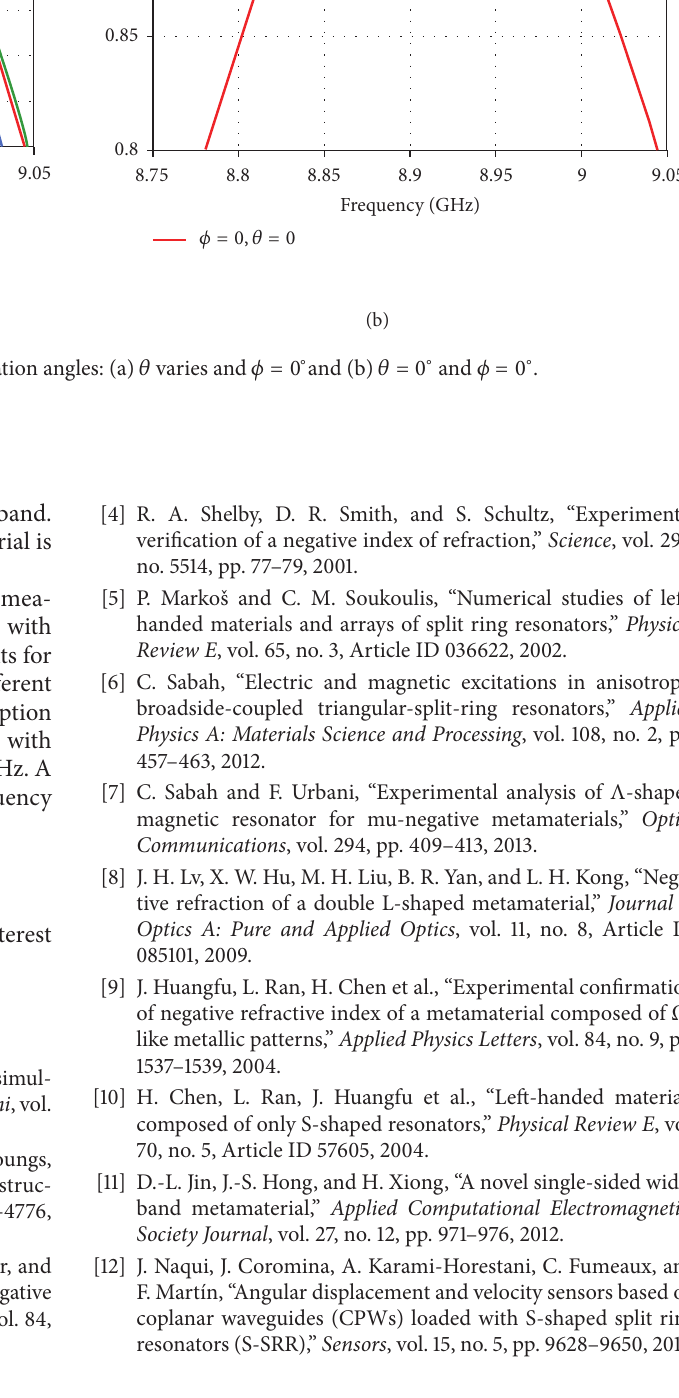
Figure 10: Absorption for different polarization angles: (a) 𝜃 varies and 𝜙 = 0 ∘ and (b) 𝜃 = 0 ∘ and 𝜙 = 0 ∘ .